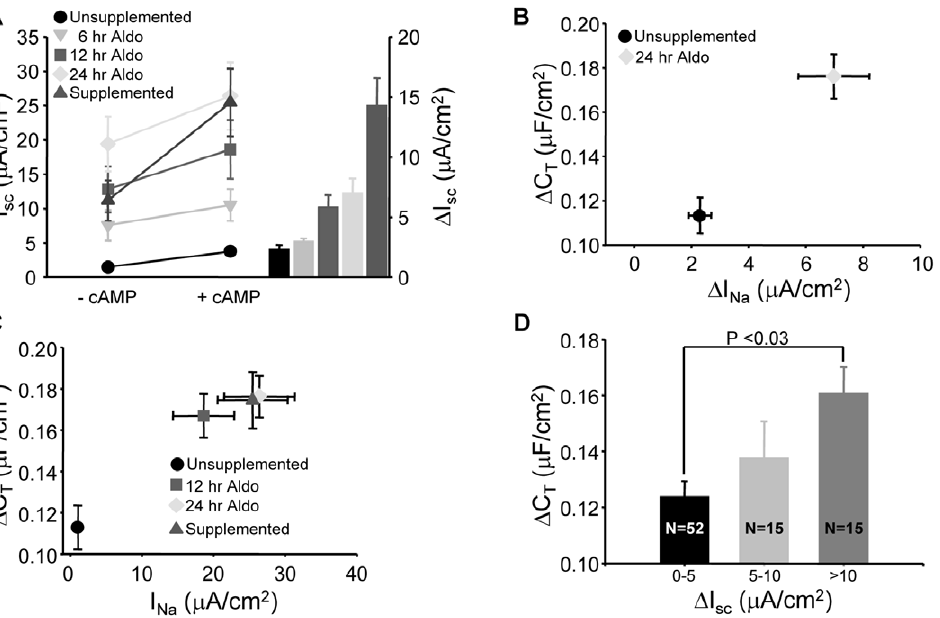
Figure 2. Aldosterone restores I SC and C T responses to cAMP stimulation. (A) Cells in unsupplemented media were incubated with 100 nM aldosterone for increasing time and stimulated with forskolin. The basal (-cAMP) and forskolin stimulated ( + cAMP) currents from cells with no aldosterone (unstimulated), 6, 12 and 24 hr aldosterone stimulation were compared to cells which received fully supplemented medium (supplemented). The average I SC response to cAMP stimulation is plotted as a bar graph on the right (n=16). (B) The change in capacitance ( D C T ) versus change in amiloride-sensitive I SC ( D I Na ) in response to forskolin stimulation is summarized for cells without supplementation and 24 hr stimulation with aldosterone. Both I SC and C T responses were significantly greater in the aldosterone treated cells compared to unsupplemented controls (n=16, p , 0.01). (C) The change in capacitance versus total stimulated ENaC I SC . The I Na and D C T of the fully supplemented cells was not significantly different from cells treated with aldosterone for either 12 hr or 24 hrs, but these 3 groups were significantly greater than cells that received no supplementation (p , 0.01). (D) Data for all recordings were pooled (regardless of supplemented state) and categorized into groups that responded to cAMP with 0–5, 5–10 and . 10 m A/cm 2 D I SC . The average D C T was then plotted for each group. A significantly larger capacitance response was observed in cells with D I SC greater than 10 m A/cm 2 compared to those with less than 5 m A/cm 2 .